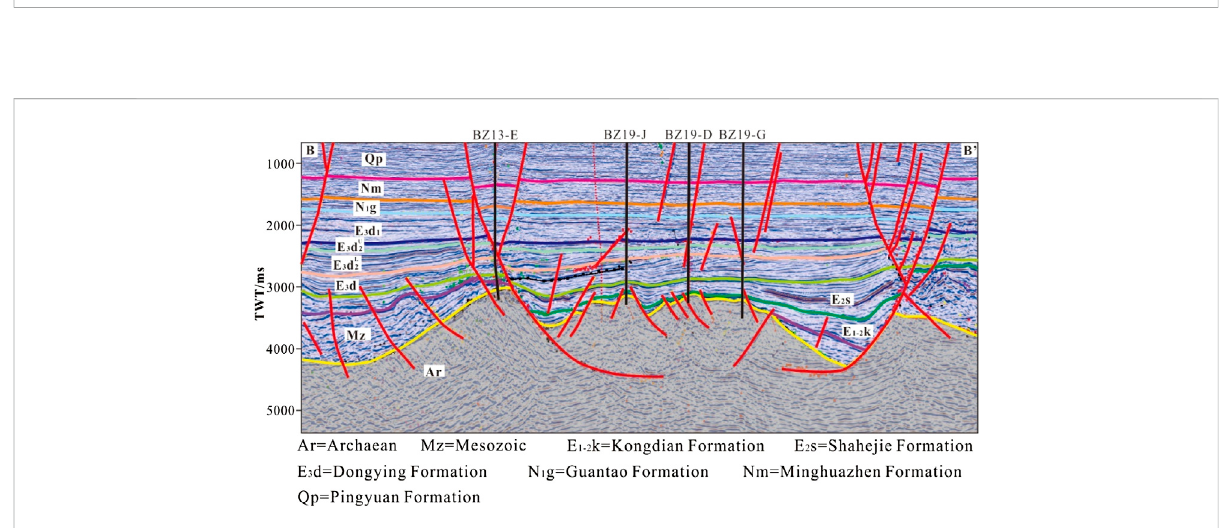
FIGURE 10 Characteristics of the seismic pro fi le along the B-B ′ line in the study area (Pro fi le position is shown in Figure 1B). A – A ’ represents the pro fi le position of Figure1C and B – B ’ represents the pro fi le position of Figure10.